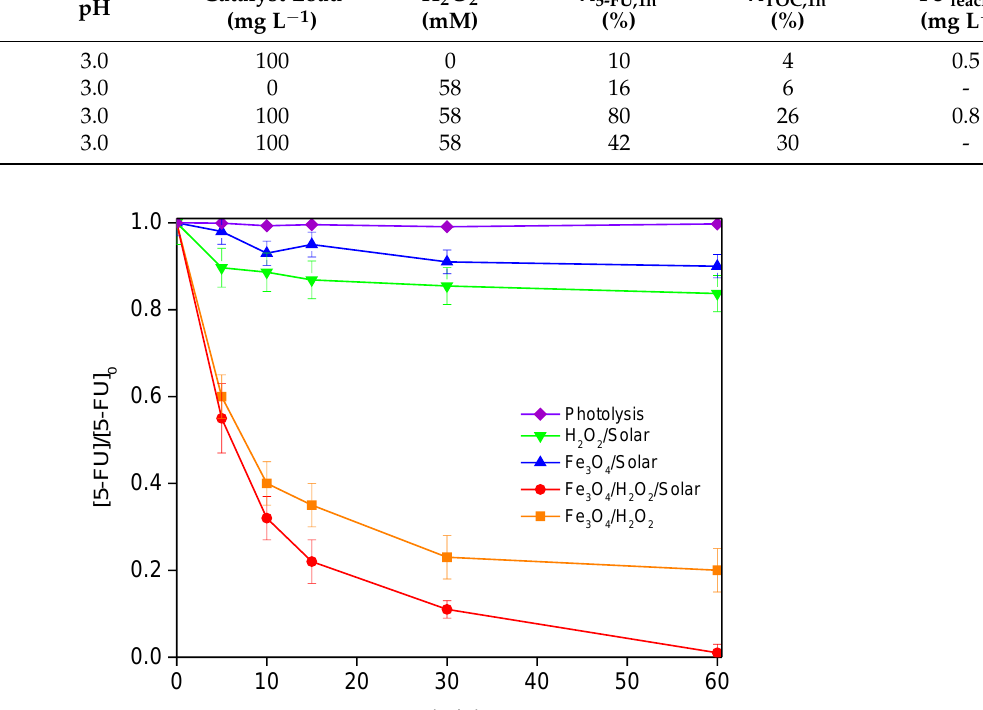
Figure 4. Degradation of 5-FU in the presence/absence of: solar radiation, H 2 O 2 , and heterogeneous catalyst (pH = 3, 58 mM of H 2 O 2 , and 100 mg L − 1 of Fe 3 O 4 Table 2 . 5-FU conversion (X 5-FU,1h ), total organic carbon conversion (X TOC,1h ), and iron-leached (Fe- leached ) for the blank experiments.